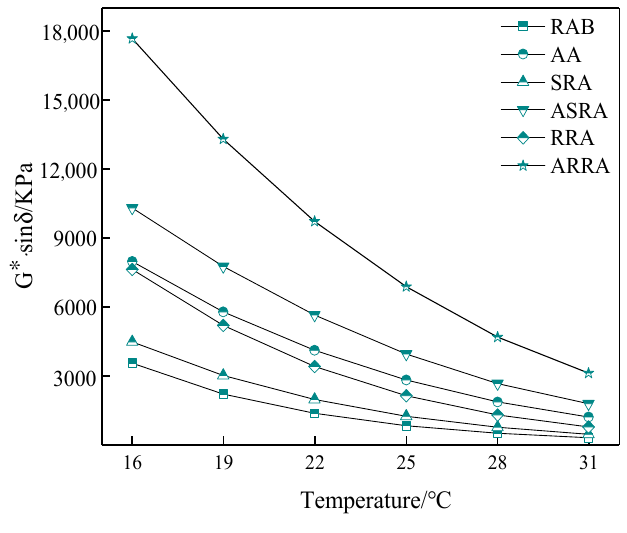
Figure 4. G*·sin δ .